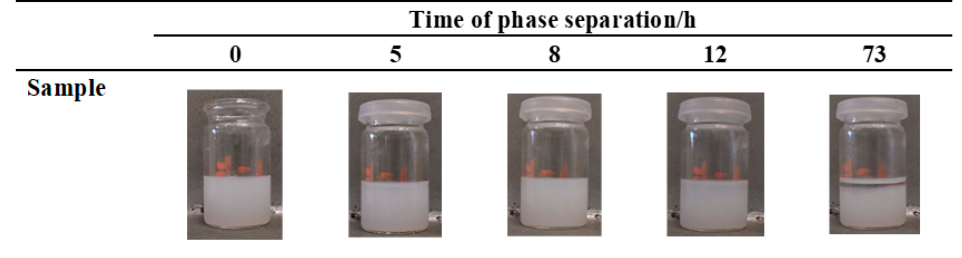
Figure 2. Digital photos of the Zr-MOF homogeneous dispersion at different times.